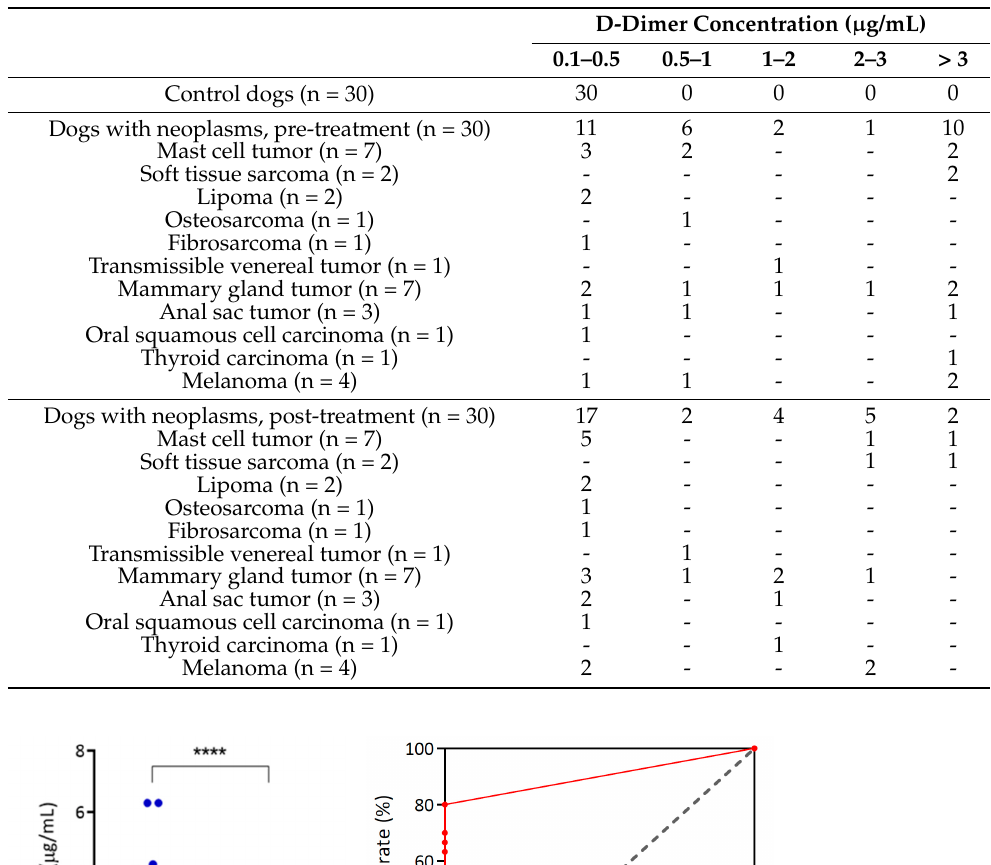
Table 1. Different D-dimer concentration distributions in control individuals and dogs with specific tumor types before and after treatment.